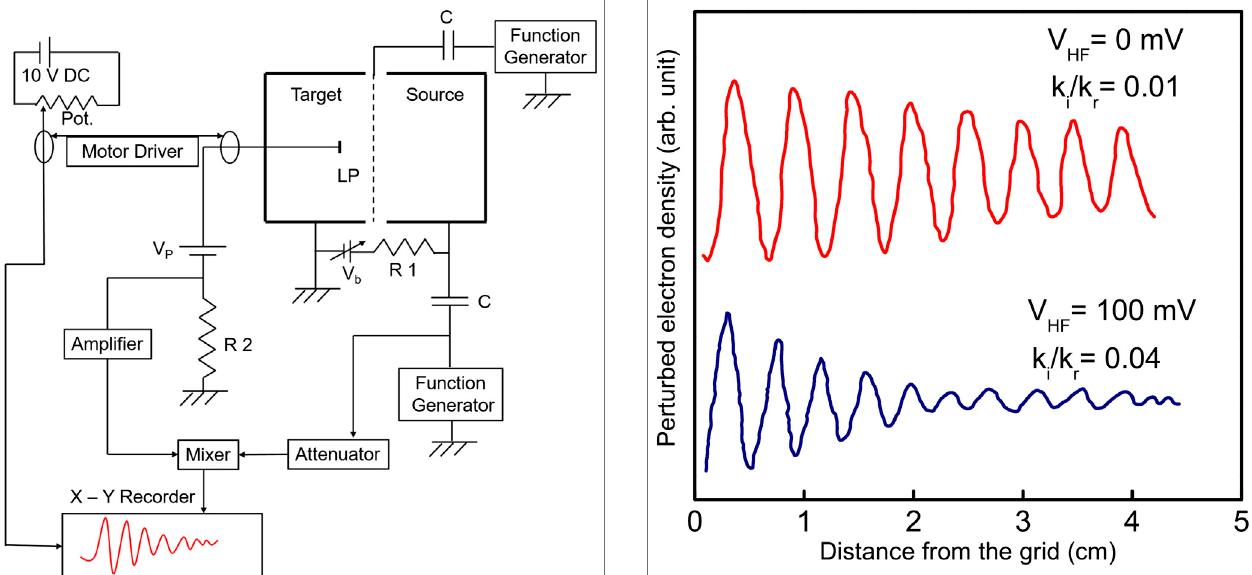
Frontiers in Physics |